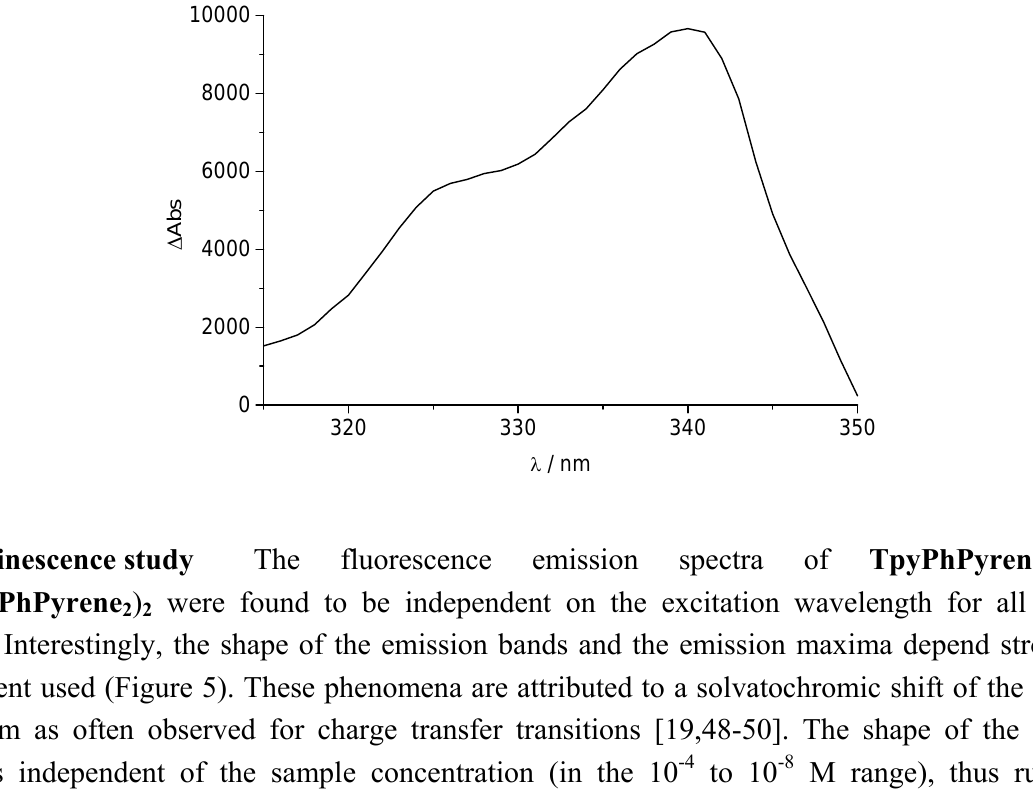
) (divided by 2) in THF. 2 2